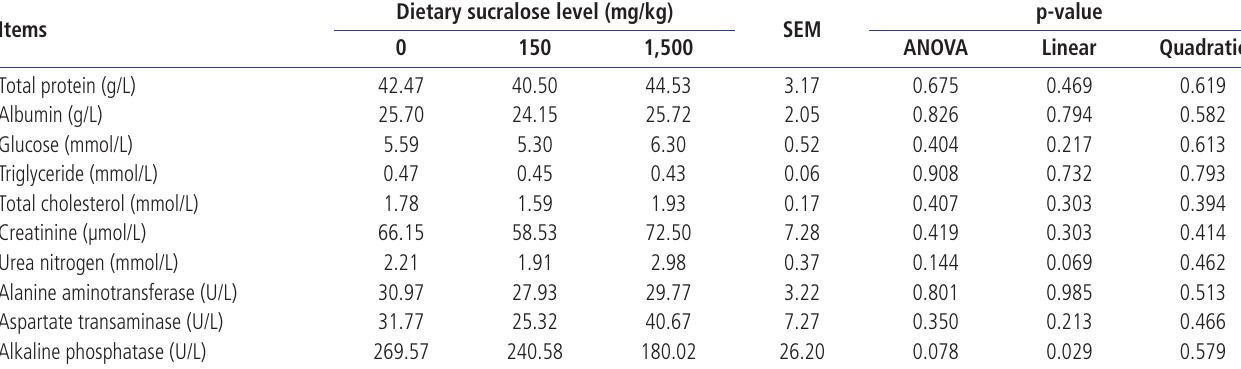
Table 6. The effects of graded levels of sucralose on serum biochemical parameters of weaned piglets (experiment 3) Items